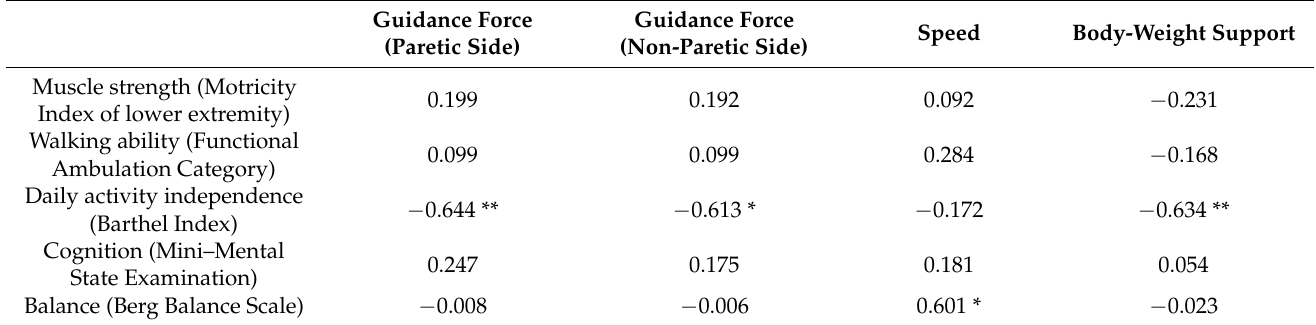
Table 6. Correlation Between Outcome Measures and RAGO Parameters in Patients with